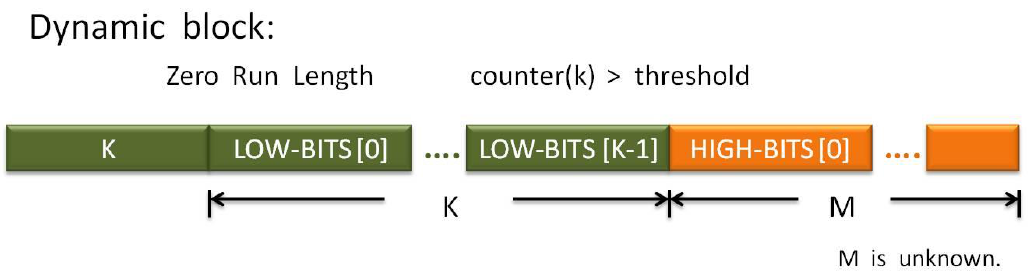
Figure 7. Dynamic-block mode output format.